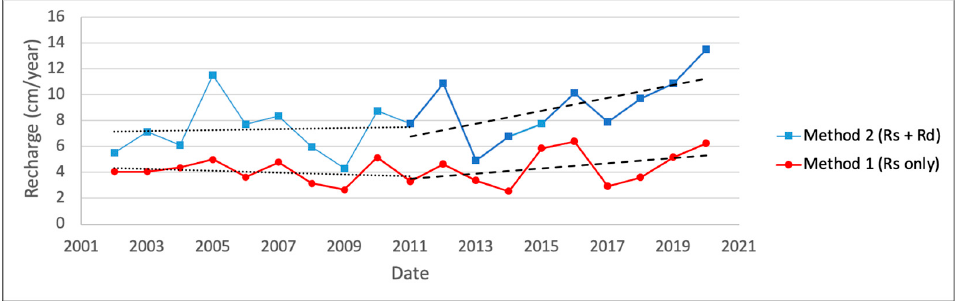
Figure 17. Estimated recharge values in the Iullemeden basins.